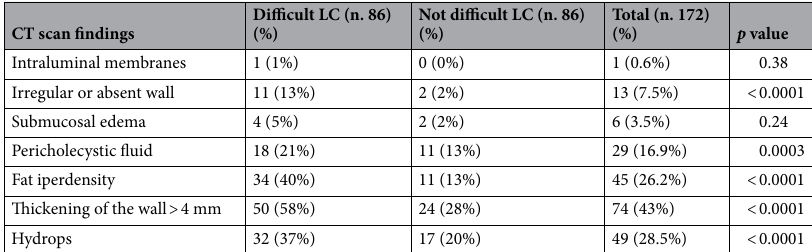
Table 2. Comparison of CT scan findings between difficult LC and not difficult LC groups.